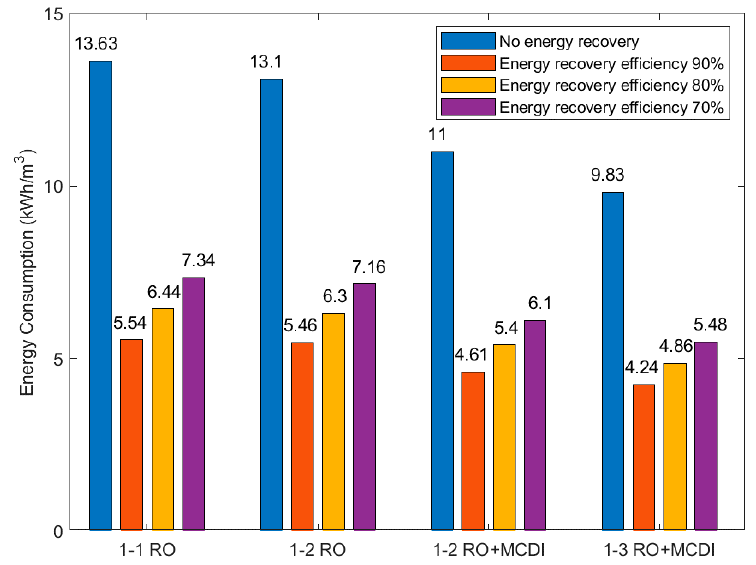
Figure 10. Comparison of energy consumption of four desalination methods.